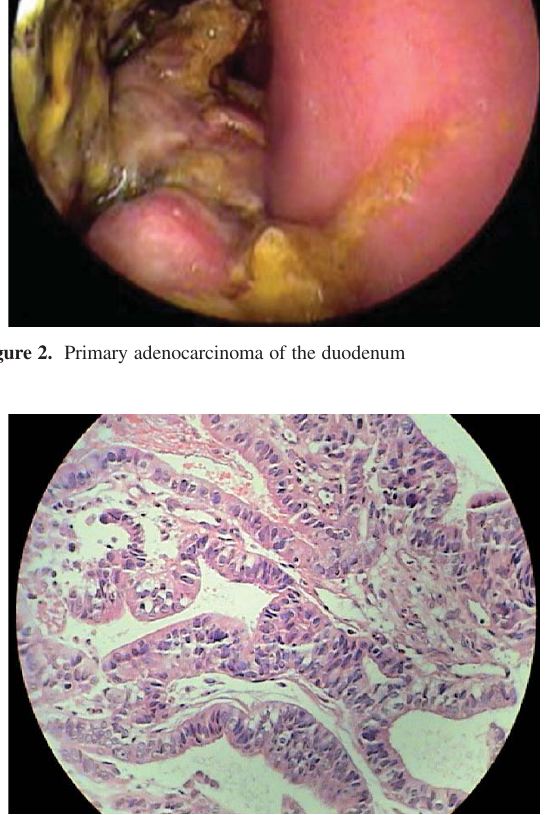
Figure 3. He (400 x) atipic glandular